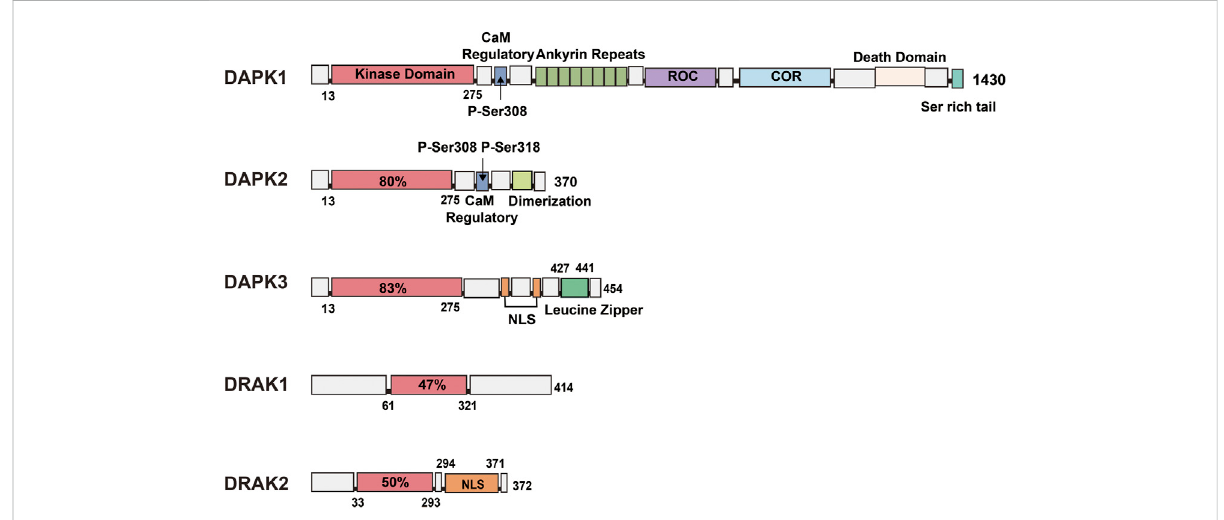
FIGURE 1 Schematic representation of the kinase structural domains and respective positions of each DAPK family member. DAPK1: In addition to the catalytic kinase structural domain, contains a CaM regulatory region, eight anchor protein repeats, ROCO structural domain, cytoskeleton binding region,deathstructuraldomainandaserine-richC-tail.DAPK2:shares80%ofthecatalyticstructuraldomainwithDAPK1,andadditionallycontainsa CaM regulatory region and a dimerization element. DAPK3: shares 83% of the catalytic structural domain with DAPK1 and contains a nuclear localization signal (NLS) sequence and a leucine zipper structural domain. DRAK1: shares only 47% of the catalytic structural domain with DAPK1. DRAK2: consists of a catalytic structural domain and a nuclear localization